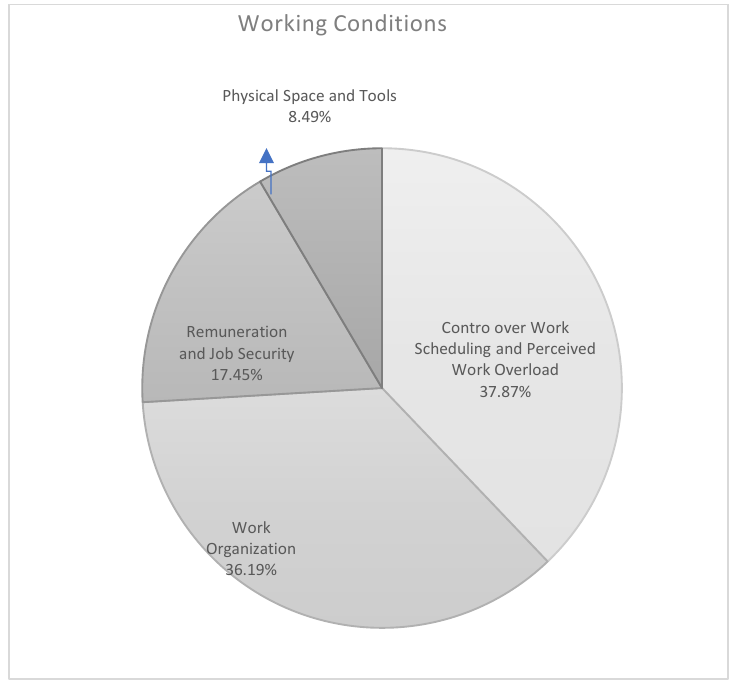
Figure 5. Theme n. 2.